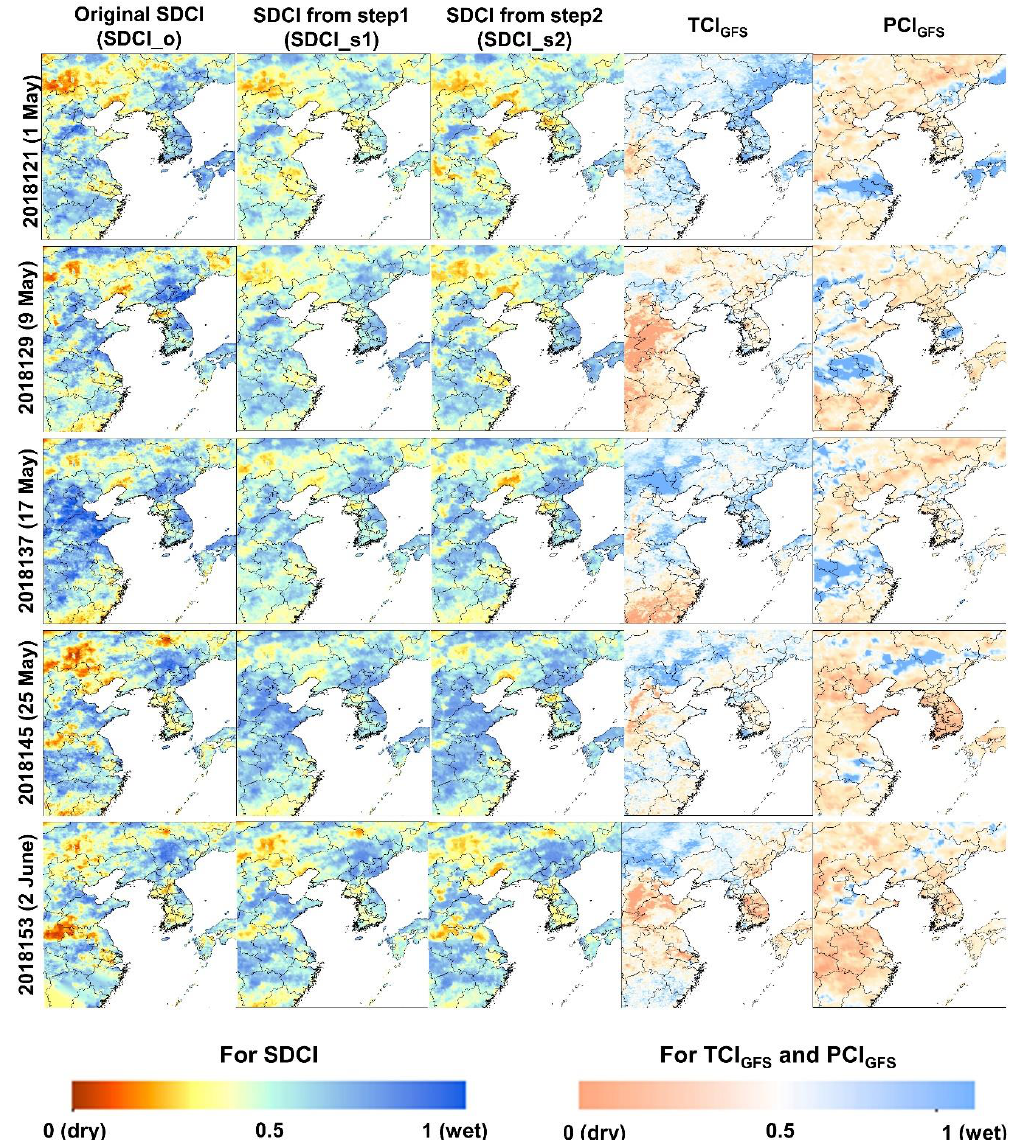
Figure 7. Spatial distribution of forecasted SDCI from 1 May to 2 June. The vivid red and blue present dry and wet conditions, respectively, in SDCI maps (i.e., reference SDCI (SDCI_o), SDCI from step 1 (SDCI_s1) and SDCI from step 2 (SDCI_s2). The light red and blue present dry and wet conditions, respectively, caused by temperature (TCI GFS ) and precipitation (PCI GFS ) from Global Forecasts System